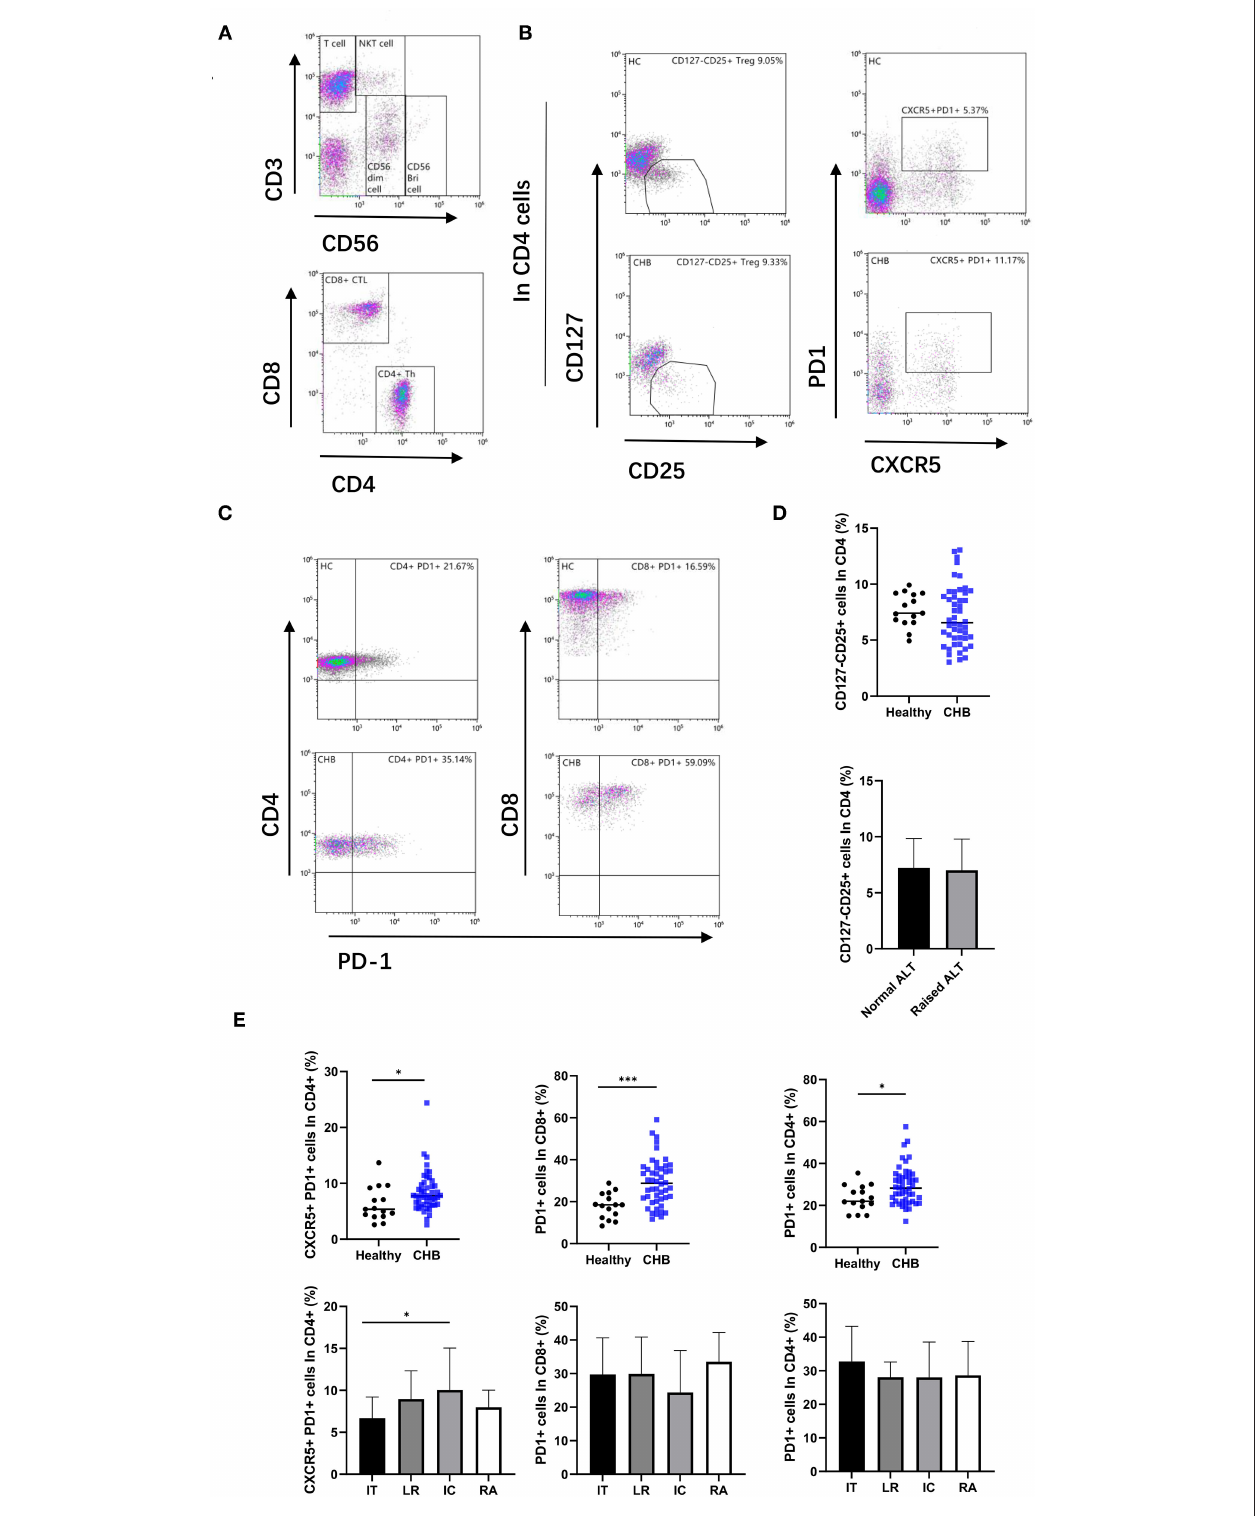
FIGURE 3 | Alter T cell subsets in CHB patient. (A) According to the expression of CD3 and CD56, lymphocytes were divided into T cell, CD56 bright NK cell, CD56 dim NK cell, and NKT cell, and then, the T cells were divided into CD4 + Th cell and CD8 + CTL cell. (B) The representative flowcytometry plot indicates the percent frequencies of Treg and cTFH cells in healthy controls and CHB patients, respectively. The gating strategy for the analysis of Treg is CD4 + CD127–CD25 + , and CD4 + PD1 + CXCR5 + plots defined as the cTFH. (C) Representative plot of PD-1 expression on CD4 and CD8T cells in different groups. (D) Comparison